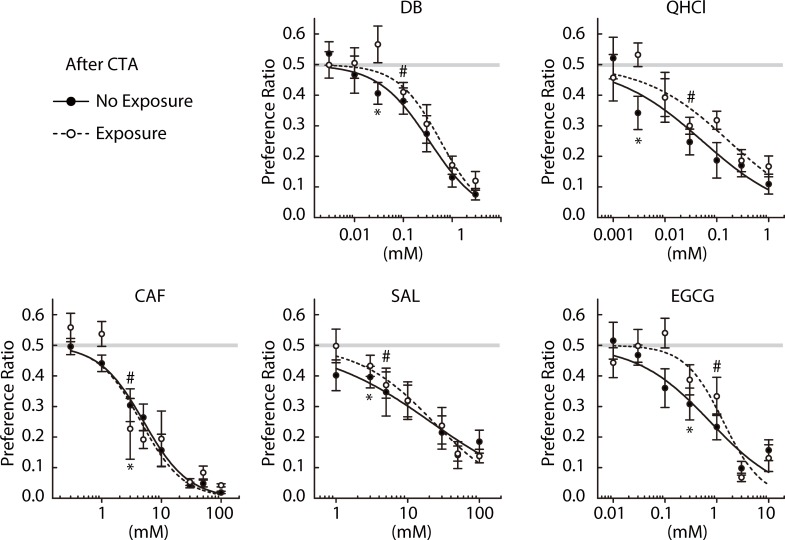
LiCl-conditioned avoidance of DB (n = 6), QHCl (n = 7), CAF (n = 7), SAL (n = 8), and EGCG (n = 6) in two-bottle choice tests after a 3-week period of exposure to the same bitter compound (open circles) superimposed on those measured without the exposure period (closed circles).# and * indicate the lowest concentrations at which preference ratios fell significantly (p < 0.05) below indifference (0.5) before and after the long bitter exposure, respectively. Solid and dashed lines represent curves fit to the average ratios for the NE and E groups, respectively. Gray lines represent the indifference level (0.5).